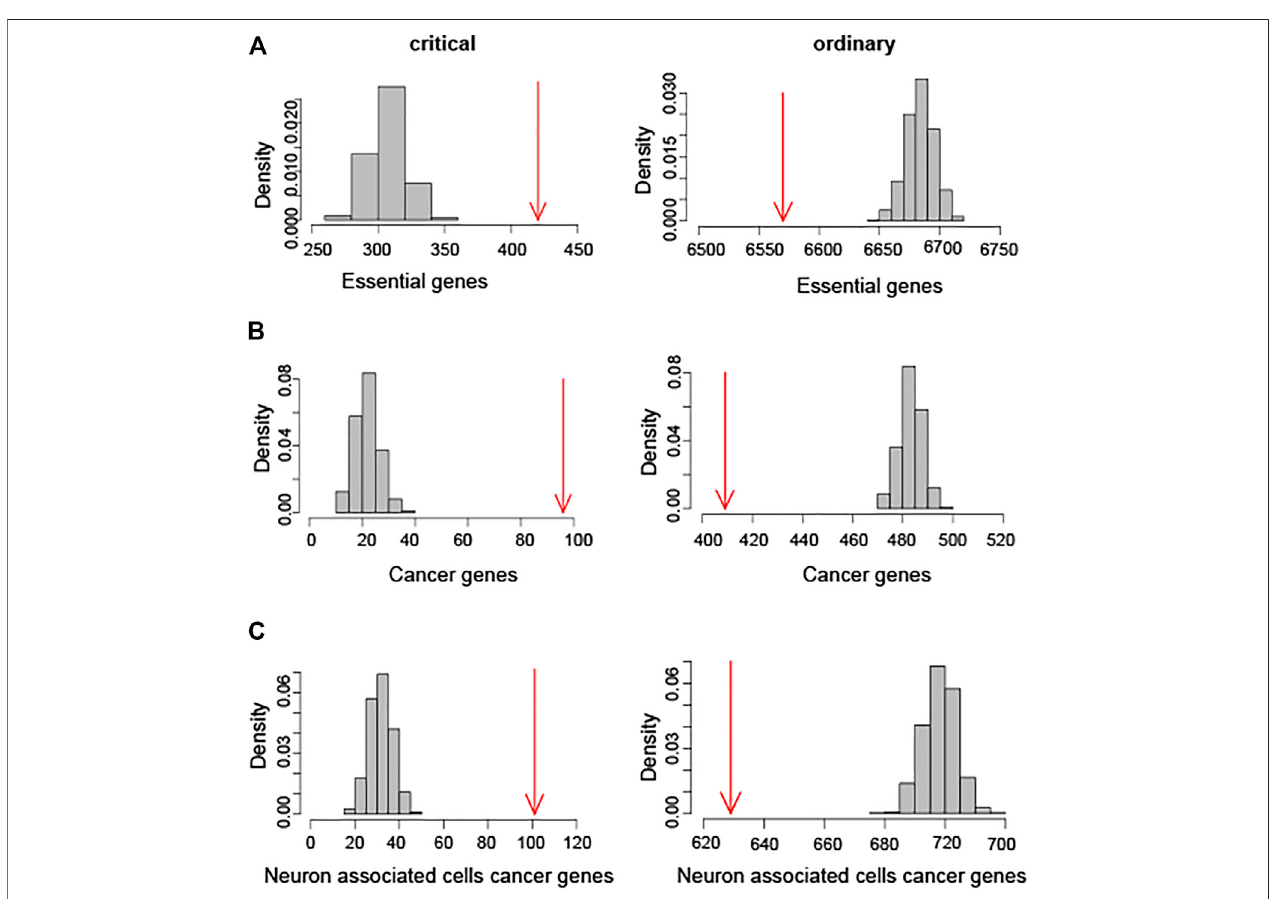
FIGURE2| BiologicalenrichmentscorecalculatinganalysisofhindbrainGRN. (A) Enrichmentanalysisofessentialgenes.Numbersofessentialgenesoverlapping withcriticalandordinarynodesareshowninredarrows. (B) Enrichmentanalysisofcancergenes.Numbersofcancergenesoverlappingwithcriticalandordinarynodes are shown in red arrows. (C) Biological enrichment analysis of neuron associated cells cancer genes. Numbers of these genes overlapping with critical and ordinary nodes are shown in red